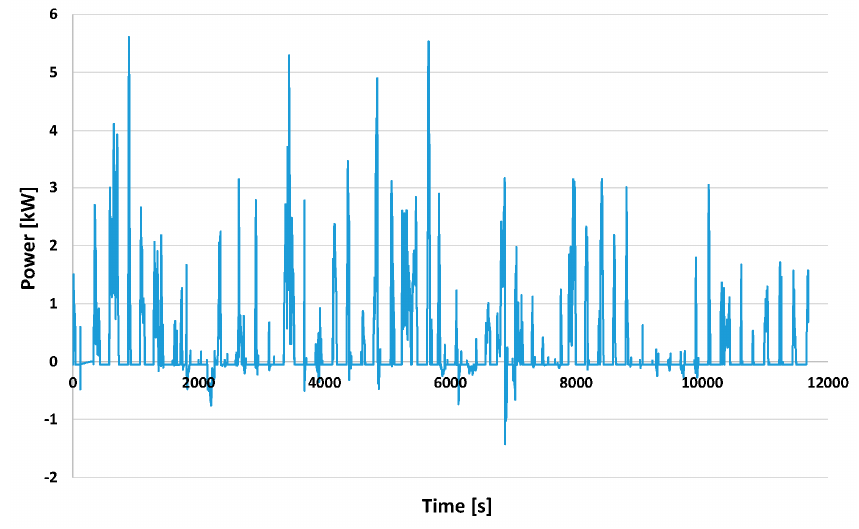
Figure 15. Instantaneous power of Electric Motor.